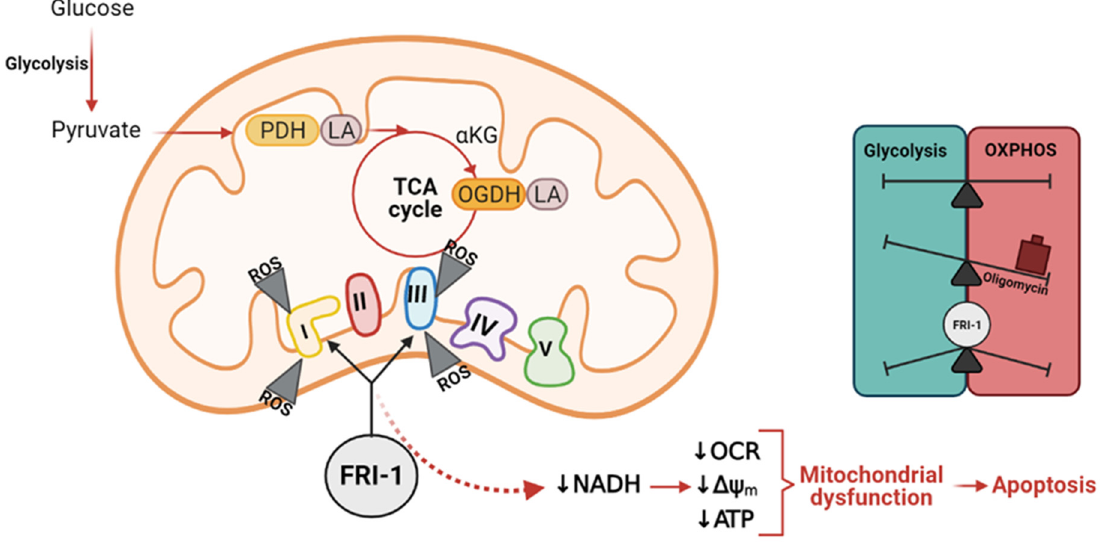
Figure 9. Mechanism of action proposed for FRI-1 compound.